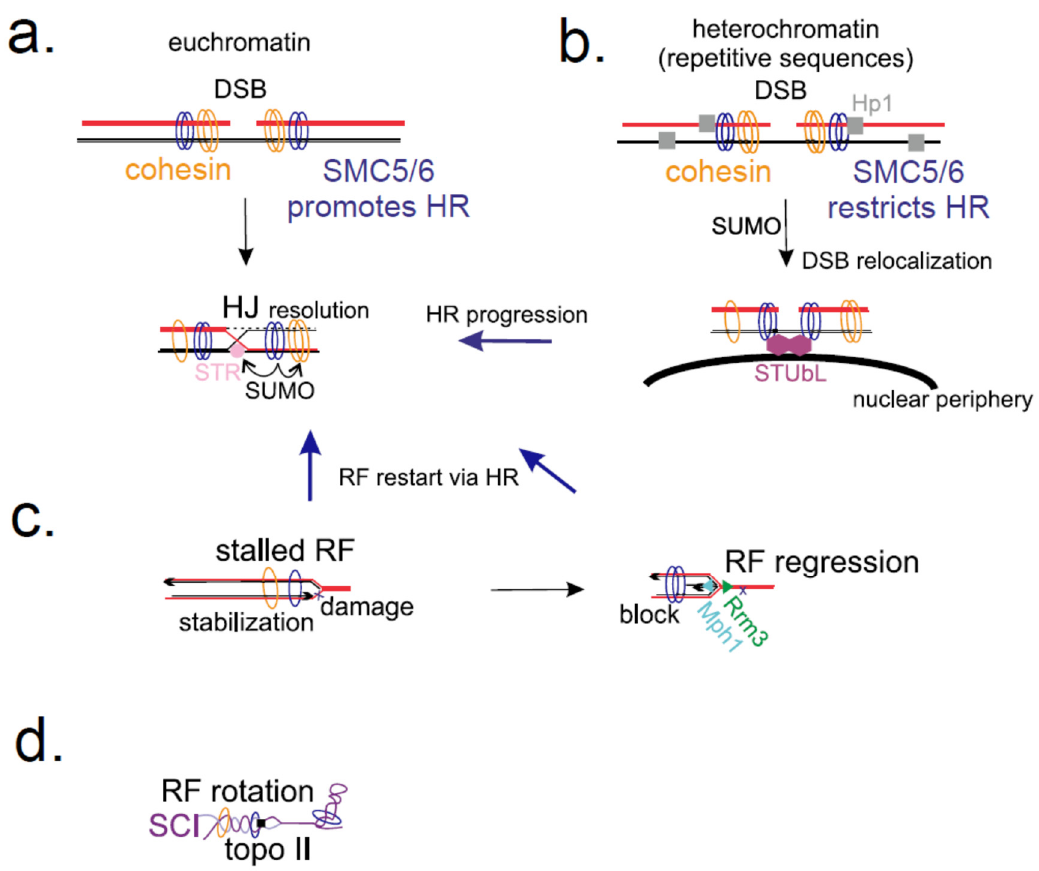
Figure 3. Multiple roles of SMC5/6 in genome integrity maintenance and replication. ( a ) SMC5/6 (blue ring) is recruited to a double-stranded break (DSB) and promotes its repair via homologous recombination (HR) in several ways. It may assist cohesin (yellow ring) in holding sister chromatids and protects it via SUMOylation. In addition, SMC5/6-dependent SUMOylation of STR (Sgs1/Top3/Rmi1; pink circle) helicase promotes resolution of the Holliday junction (HJ). ( b ) SMC5/6 binds heterochromatin protein 1 (HP1; grey square) and blocks HR within the heterochromatin domain to prevent ectopic recombination. Nse2-mediated SUMOylation triggers the relocalization of repair sites to nuclear periphery, where Smc5/6 interacts with the SUMO-targeted ubiquitin-ligase (STUbL) complex (violet hexagon), which ubiquitylates SUMOylated proteins and enables HR progression (blue arrow) outside the heterochromatin domain. ( c ) SMC5/6 localizes to stalled replication fork (RF) and assists in its restart via HR when it collapses (blue arrow). SMC5/6 restricts RF regression (which would otherwise also lead to HR; blue arrow) promoted by Mph1/FANCM helicase (cyan triangle). Pausing sites (such as repetitive ribosomal DNA (rDNA)) are particularly prone to RF regression. The Rrm3 helicase (green triangle) facilitates replication through such pausing sites. ( d ) SMC5/6 promotes RF rotation to relax topological tensions (by topoisomerase II; black square) and remove sister chromatid intertwines (SCI) during replication.